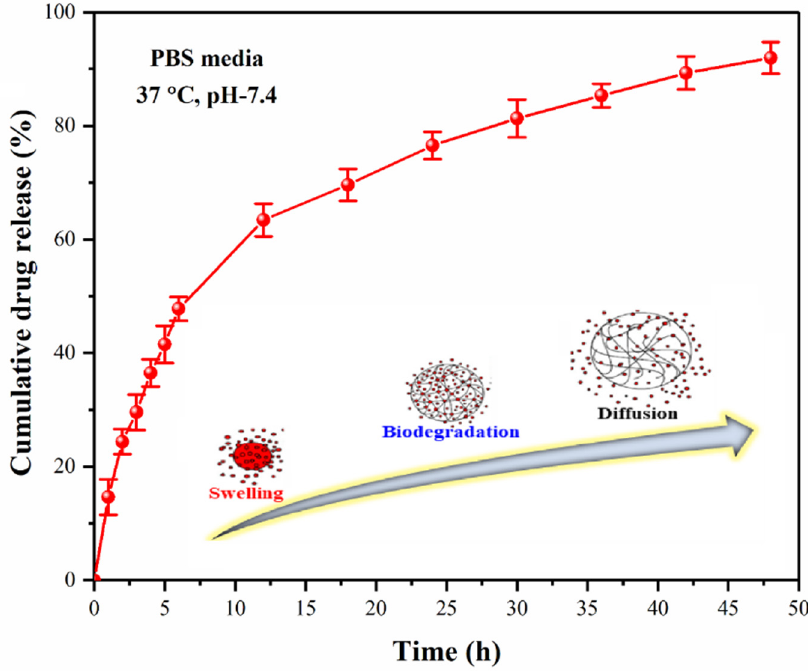
Figure 7. The Franz diffusion drug release profile of BCH-3 hydrogel was studied under in vitro conditions.